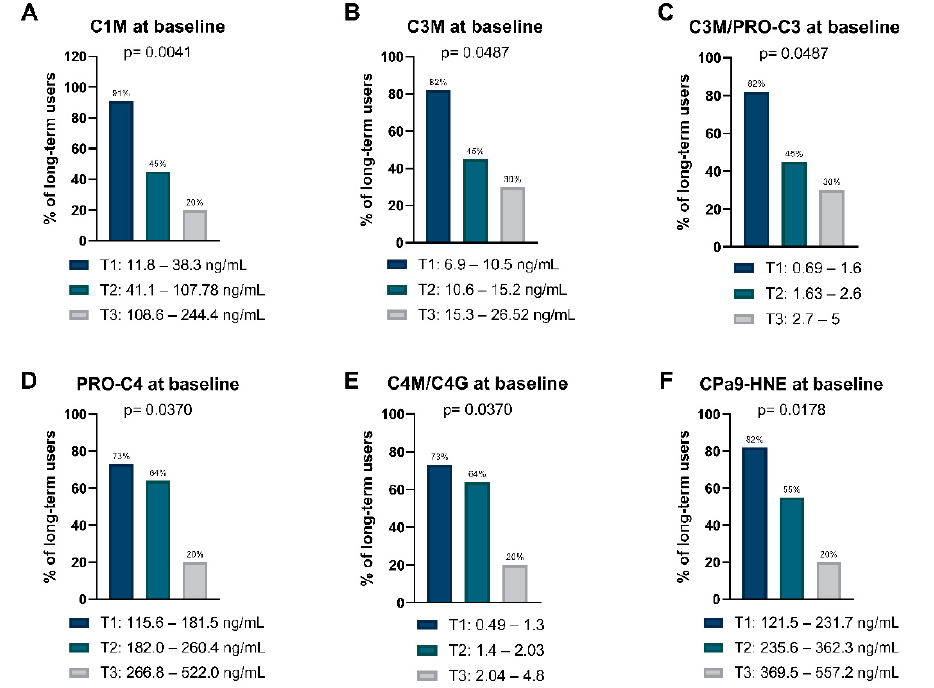
Figure 3. ( A – E ) Tertile biomarker levels of type I, III, and IV collagen degradation, BM turnover, type III and IV collagen turnover, as well as ( F ) serum calprotectin. Bars represent the percentage (%) of patients who became long-term users within each tertile, with their corresponding ranges listed below.